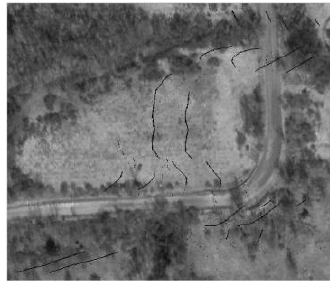
Figure 9: Failed detection using Ribbon Snake